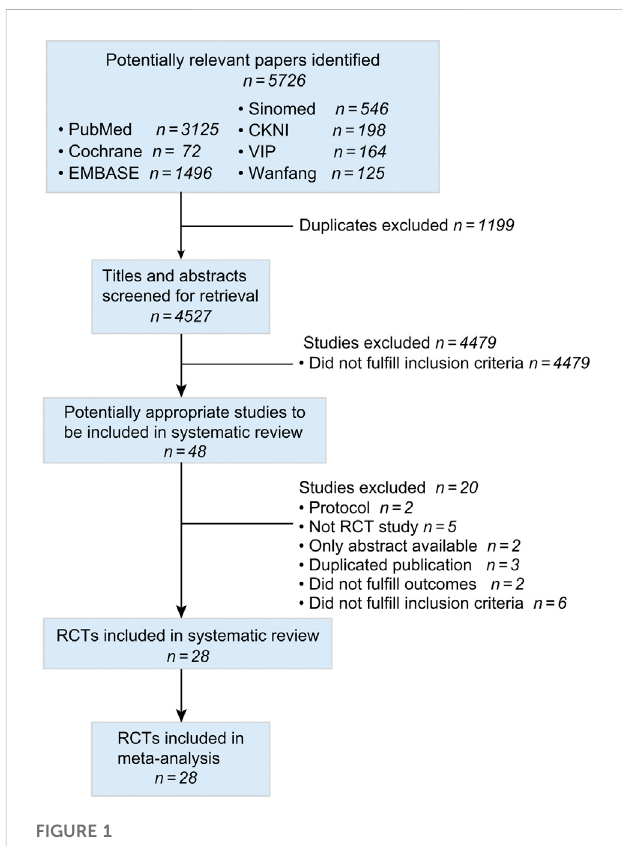
FIGURE 1 The PRISMA study fl owchart of study